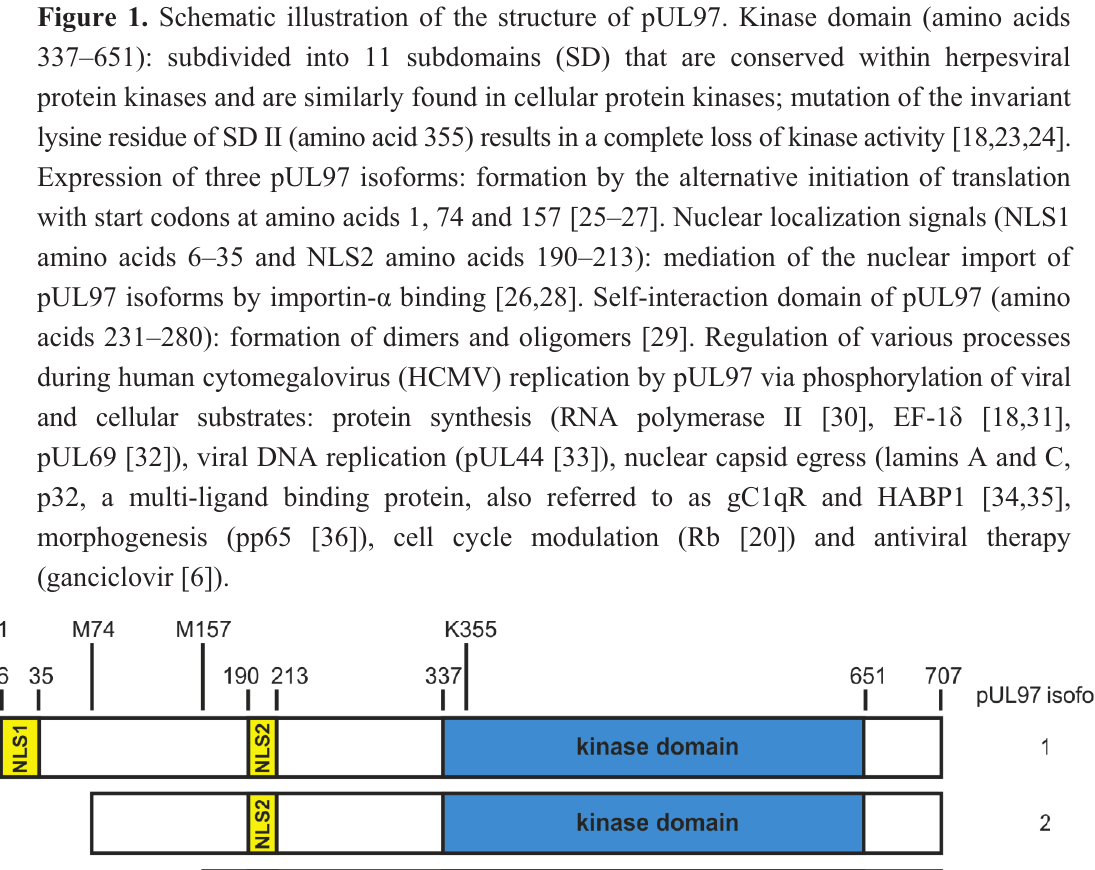
Figure 1. Schematic illustration of the structure of pUL97. Kinase domain (amino